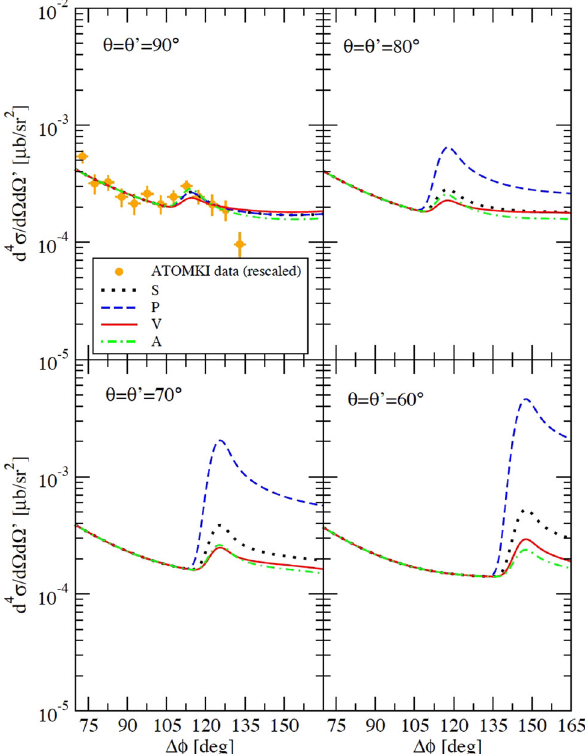
Fig. 17 The cross section for the 3 H(p,e + e − ) 4 He process at 0 . 90 MeV incident proton energy for several configurations in which the e + and e − momenta are emitted at angles θ = θ (cid:4) with respect to the incident proton momentum, and as function of the difference Δφ = φ (cid:4) − φ . The curves labeled S, P, V, and A show the results obtained by including the exchange of a scalar, pseudoscalar, vector, and axial X17, respectively. In all cases, it is assumed M X 17 = 17 MeV. The coupling constants have been adjusted so as to reproduce the ATOMKI 3 H ( p , e + e − ) 4 He cross section data at the incident proton energy of 0.90 MeV and in which θ = θ (cid:4) = 90 o . See [67] for more details